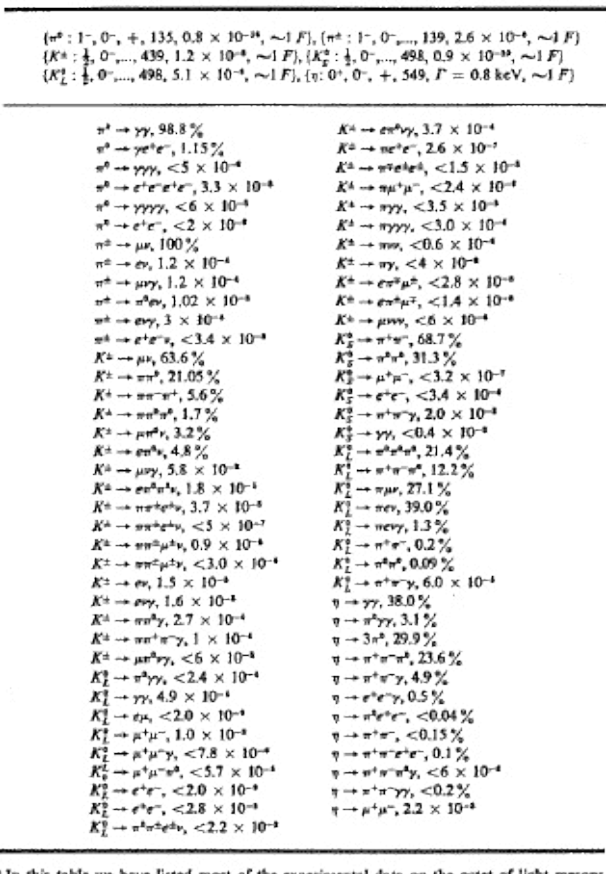
Figure 3: A reproduction of Table 1, page 429, Ref. [20] used to identify the physical constituents of mesons in the massive particles produced free in the spontaneous decays, generally those with the lowest mode. The “completion” of quantum mechanics into hadronic mechanics then becomes recommendable for any quantitative treatment of the indicated structure